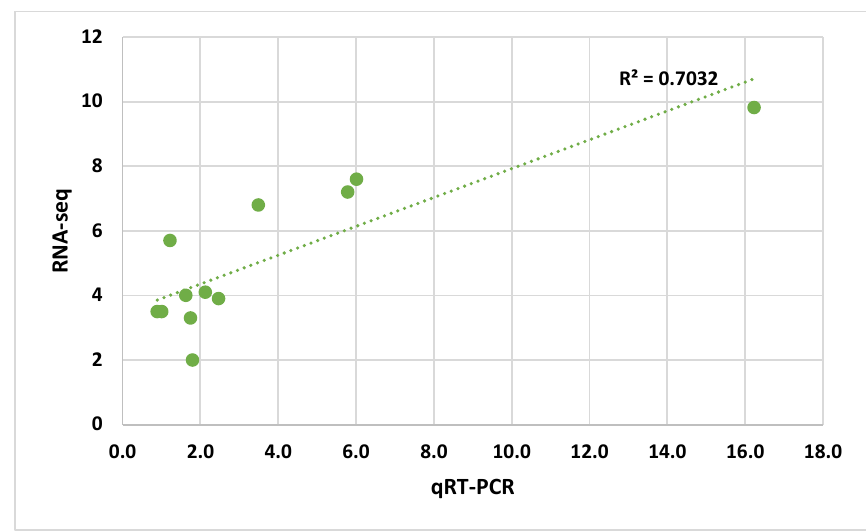
Figure 3. Gene expression correlation between RNA-sequencing (RNA-Seq) and quantitative real-time polymerase chain reaction (qRT-PCR) data. Each green dot indicates the selected genes at the Py3—48 h and Py4—7 days time points (n = 12).